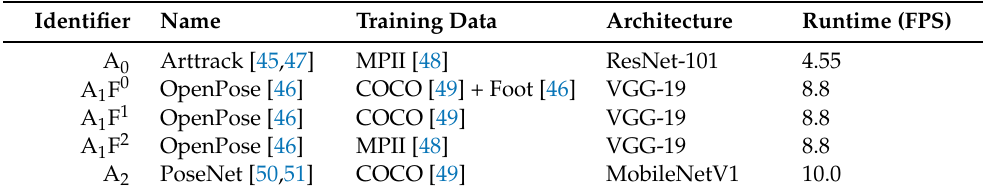
Table 2. Resulting three algorithms. A 1 comes in three different flavors F 0 – F 2 , such that a total of five algorithms can be compared to each